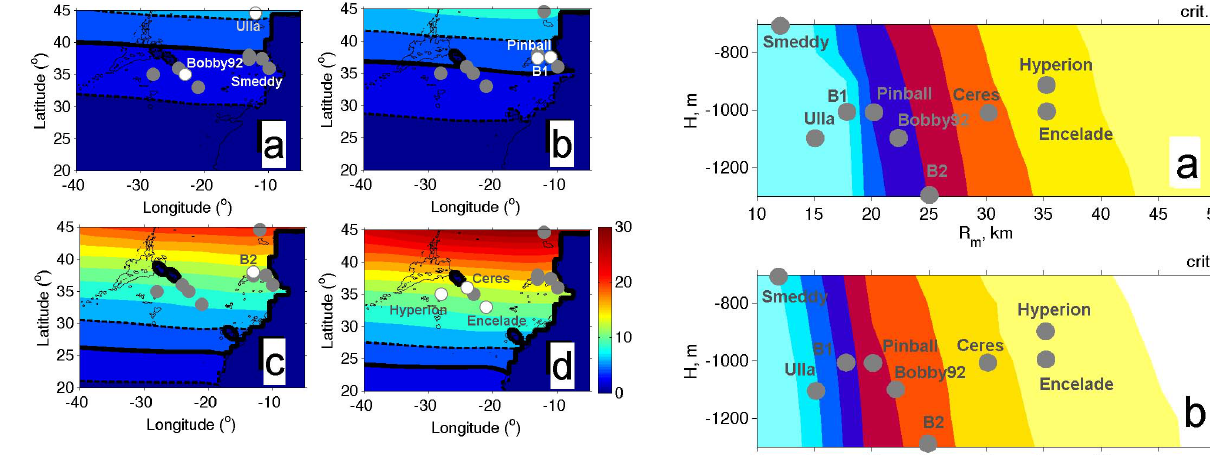
Fig. 8. Sea-level anomaly (cm): (a) H =1100m, R m =20km; (b) H =800m, R m =20km, (c) H =1100m, R m =30km, (d) H =800m, R m =30km. The thick black line marks the critical value ζ =4cm, while its position varies within the limits of the dashes lines when a ± 2cm interval for detectable signals is intro- duced. The buoyancy frequency was obtained from the mean cli- matic density field (WOA09). Grey filled-in circles mark the med- dies described in the text (Table 1); white filled-in circles are the meddies with [ H,R m ] characteristics close to those presented in the respective panel.